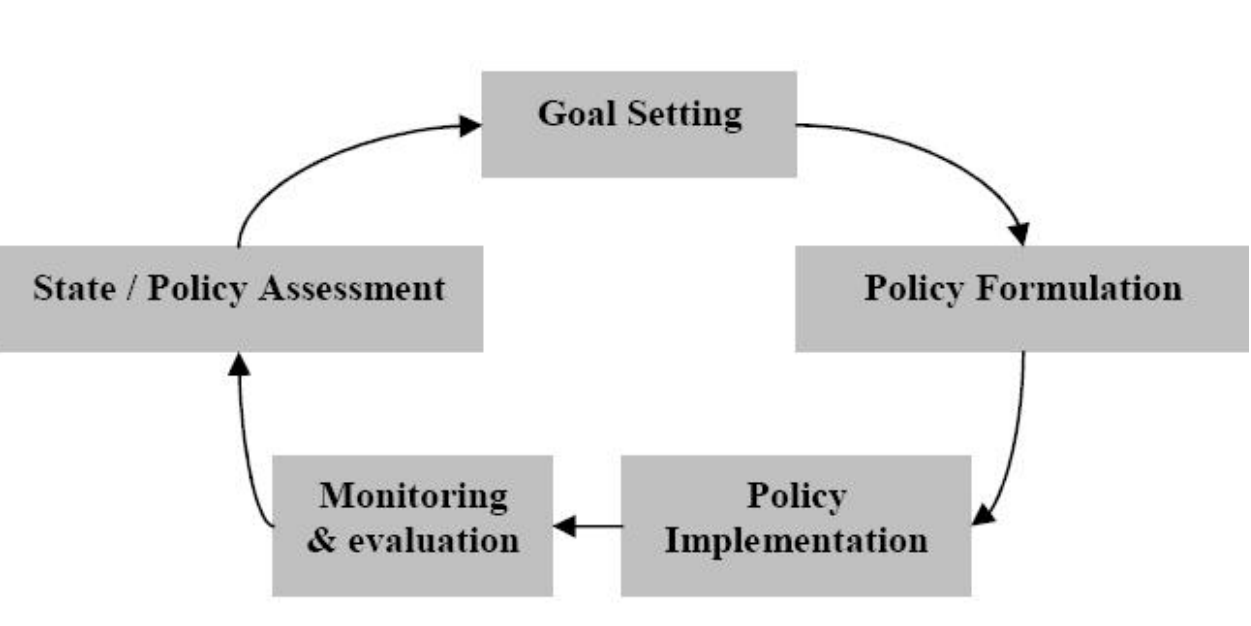
Fig. 1. The adaptive management cycle (Pahl-Wostl